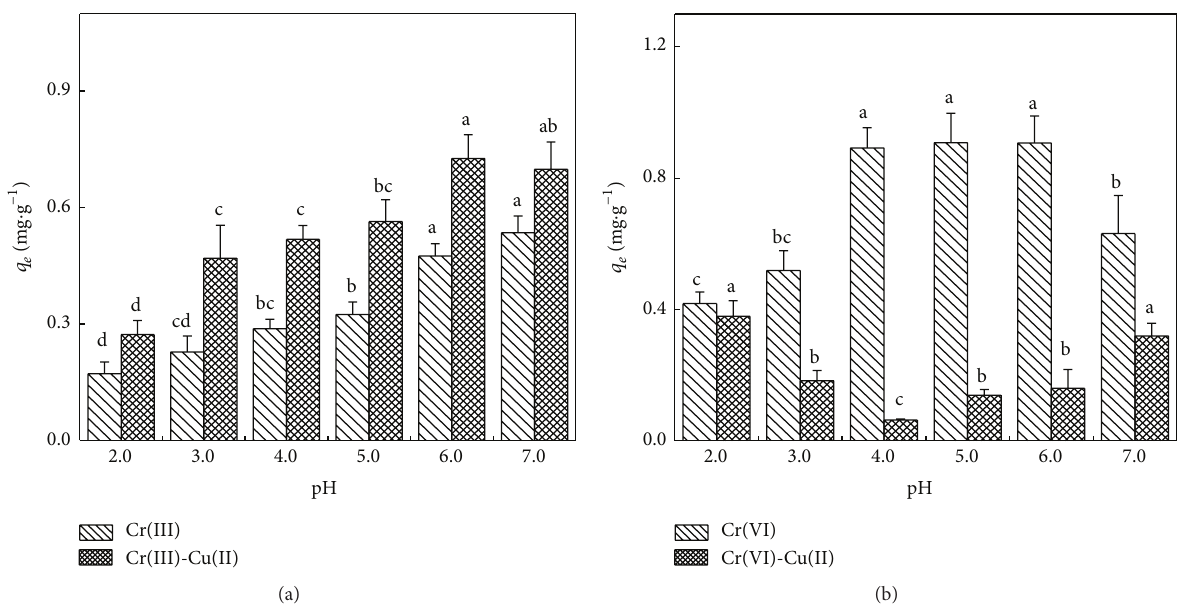
Figure 4: Influence of pH on the adsorption capacities of Cr(III) (a) or Cr(VI) (b) onto kaolin. Note: the lowercase letters in figure above are the 5% significant level by using LSD method under the same Cr treatment, but under different pH (adsorption conditions: 𝑐 0 = 300 mg ⋅ L −1 for Cr(III), 𝑐 0 = 200 mg ⋅ L −1 for Cr(VI), 𝑉 = 20 mL, 𝑚 = 0.50 g, temperature = 25 ∘ C, and equilibrium time = 120 min).